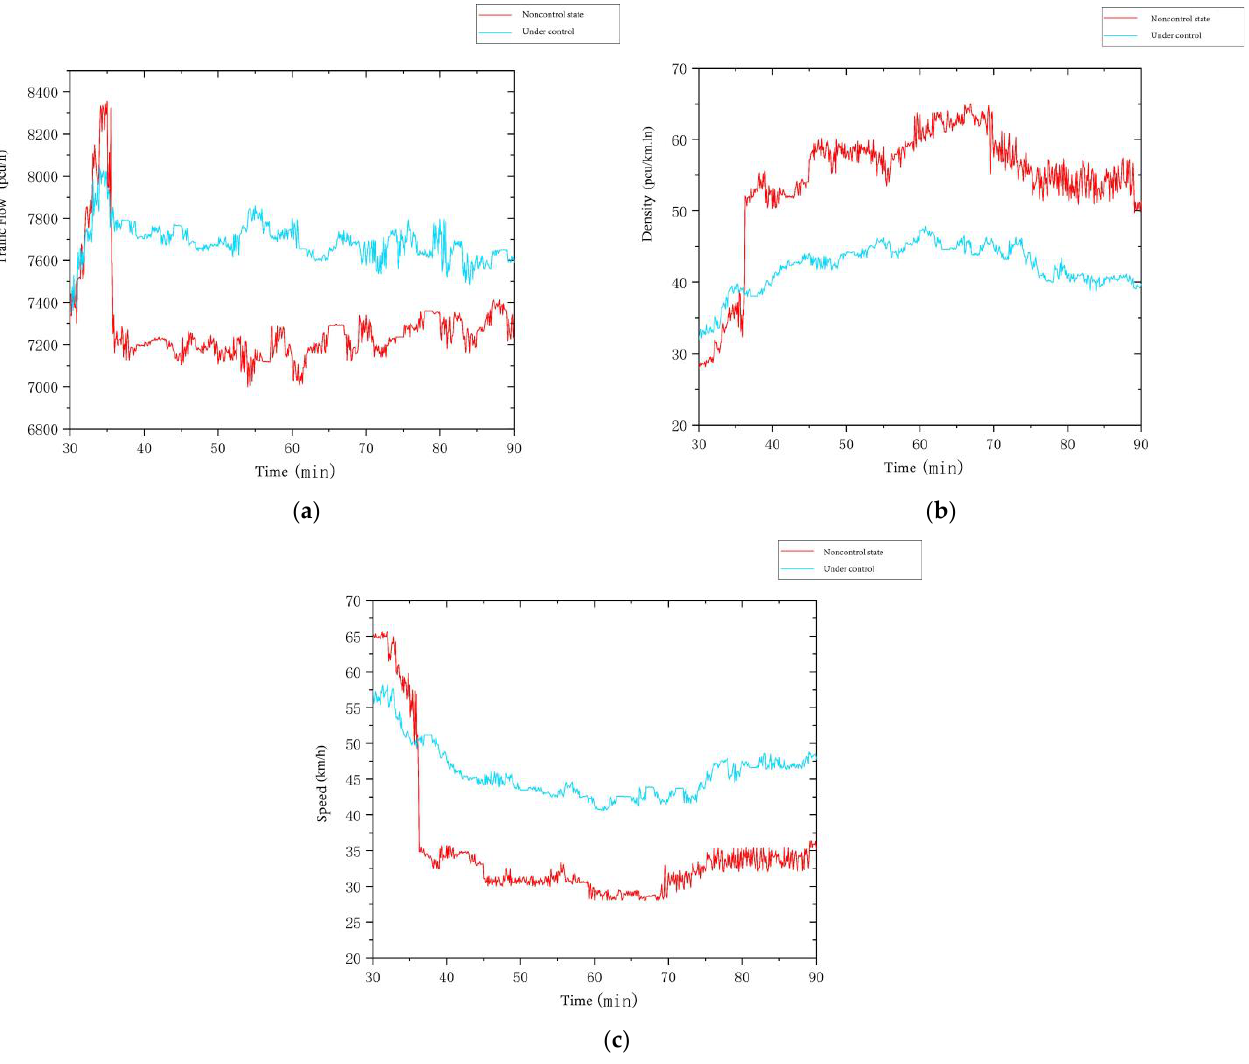
Figure 18. Flow, density, and speed curves under uncontrolled and cooperative control. ( a ) Flow curve; ( b ) Density curve; ( c ) Speed curve.